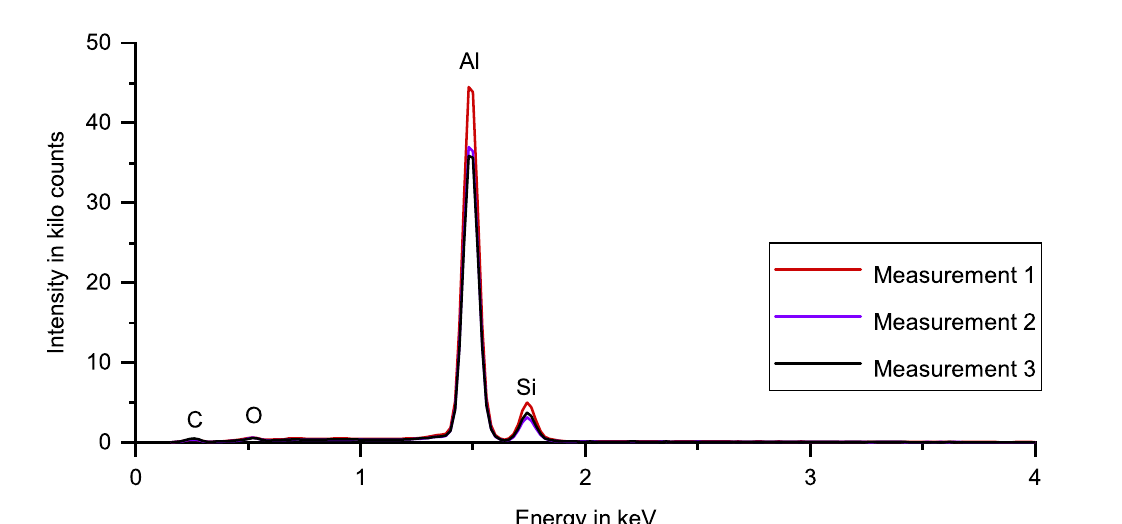
Figure 10. Three spectra for the SA-sample, superimposed in a single diagram. Aluminum, silicon, carbon and oxygen were detected. The three spectra differ in peak height, the peak positions do not change.